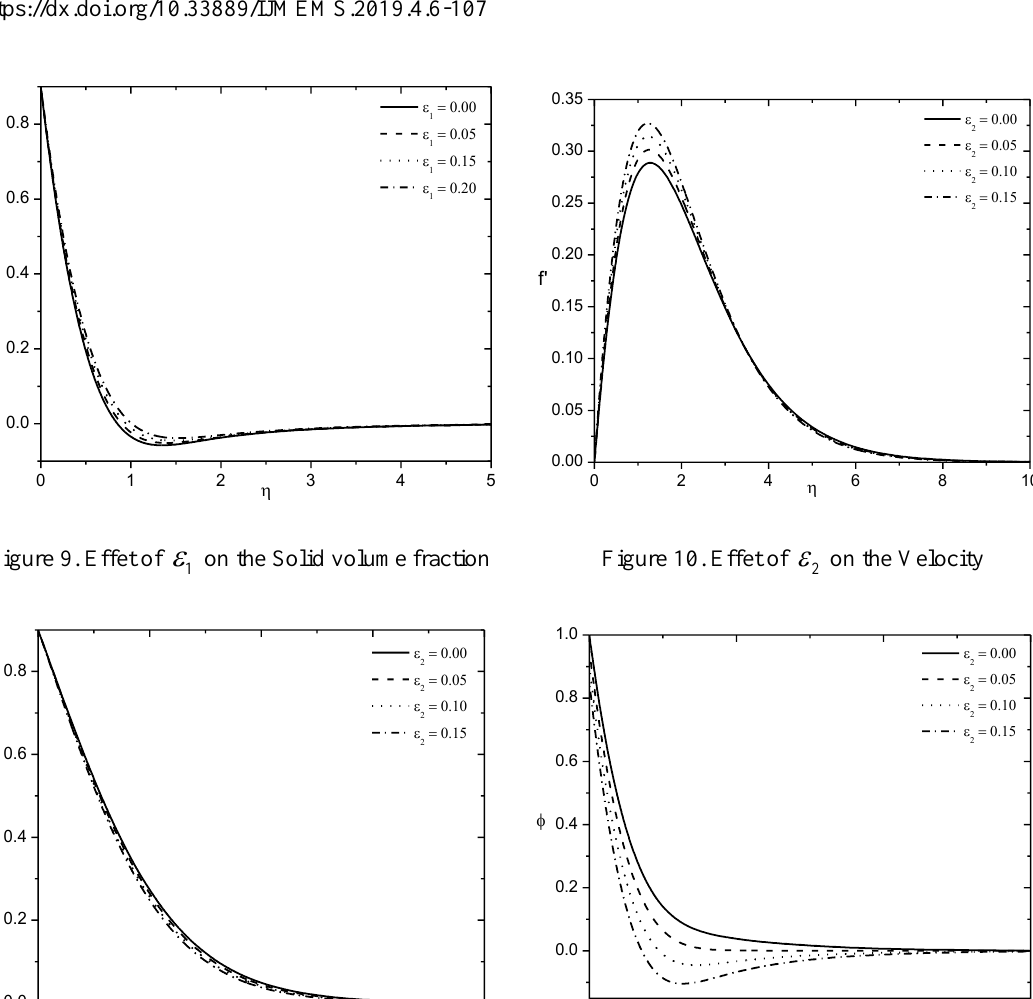
 on the Solid volume 2